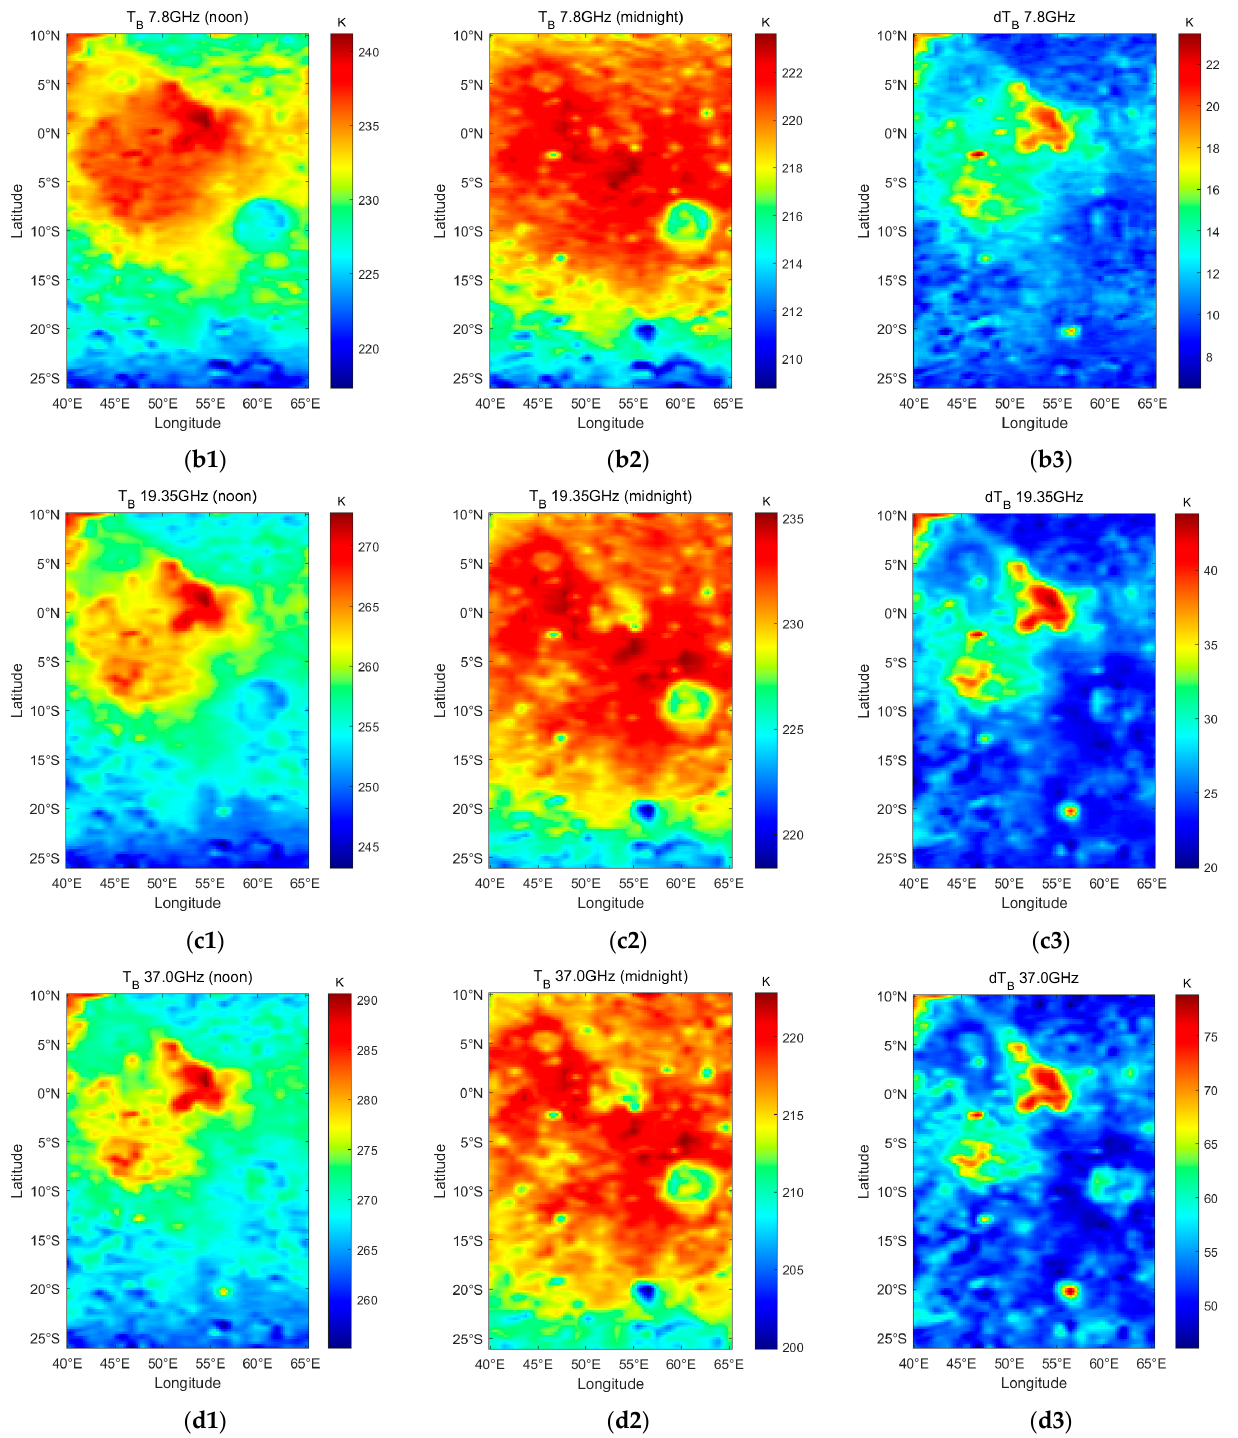
Figure 2. T B and dT B feature maps of Mare Fecunditatis. ( a ) 3.0 GHz T B features; ( b ) 7.8 GHz T B features; ( c ) 19.35 GHz T B features; ( d ) 37.0 GHz T B features; ( 1 ) T B noon features; ( 2 ) T B midnight features; ( 3 ) dT B features. Kramer et al., divided Mare Fecunditatis into fi ve units, according to the FTA (FeO + TiO 2 abundance) [30]—Ihtm (a late(?) Imbrian, mid- to high-Ti, high-Fe mare basalt), Chtr